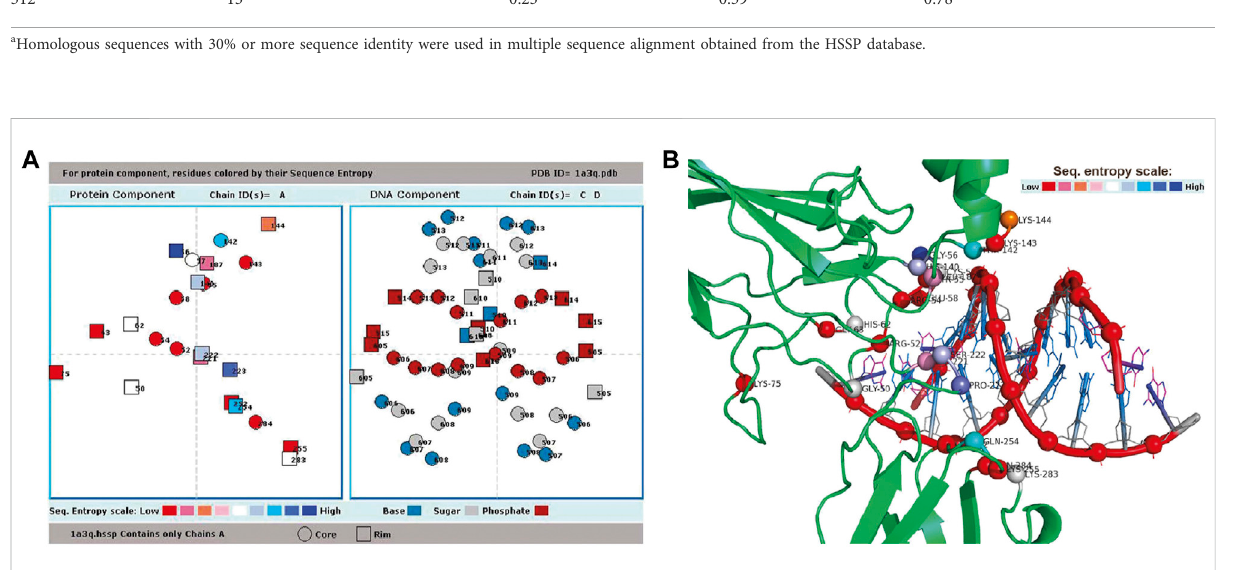
FIGURE 2 Result page of ProDFace. (A) Plot showing relative positions of the residues from one subunit (whose sequence entropies are shown color- coded, and also as circles and squares, depending on their location in core and rim, respectively) and nucleotides (separated into base, sugar and phosphate, shown in three distinct colors, and also distinguished into core and rim) in the fi le 1a3q.pdb (human NF-kappaB p52 homodimer-DNA complexasinput). (B) CartoonrepresentationofhumanNF-kappaBp52homodimer-DNAcomplex(PDBcode,1a3q,onlyonesubunitshown), approximately in the orientation used in Figure 2A for displaying interface residues and nucleotides. Interface C α atoms are shown as spheres and colored according to sequence entropy. DNA backbone is shown in red (phosphate in sphere), whereas base and sugar are shown in blue and gray sticks, respectively. Figure made using pymol